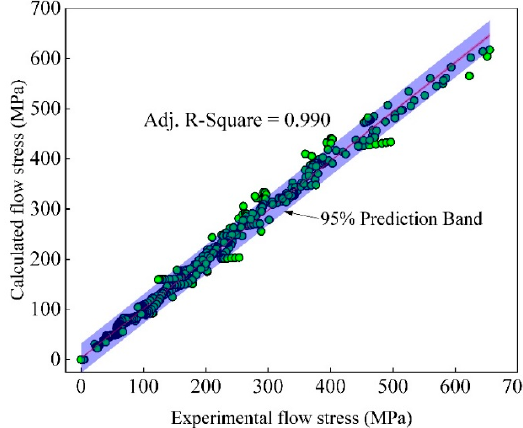
Figure 6. Scatter plots of the calculated versus experimental flow stress.